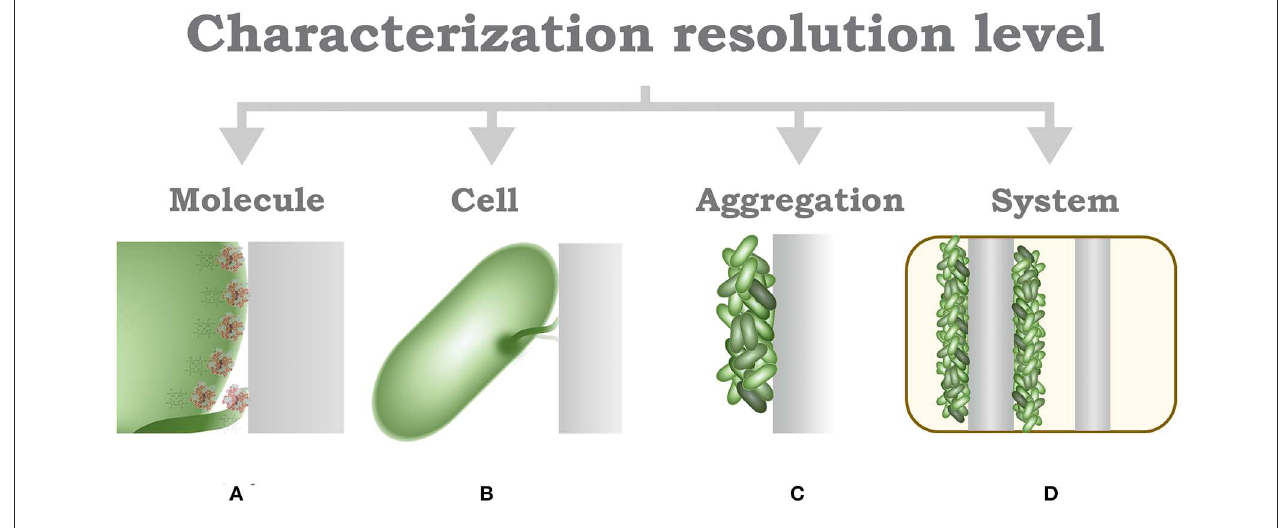
FIGURE 5 | Schematic characterization of resolution hierarchical level characterization. (A) Molecule-level characterization. (B) Cell-level characterization. (C) Aggregation-level characterization. (D) System-level characterization.